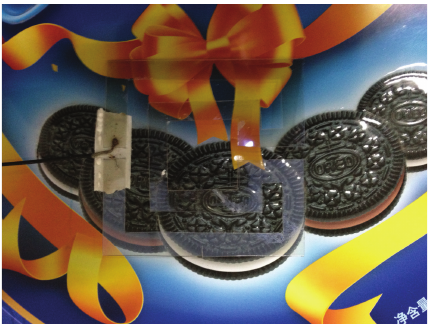
Figure 3: Photograph of the fabricated antenna.